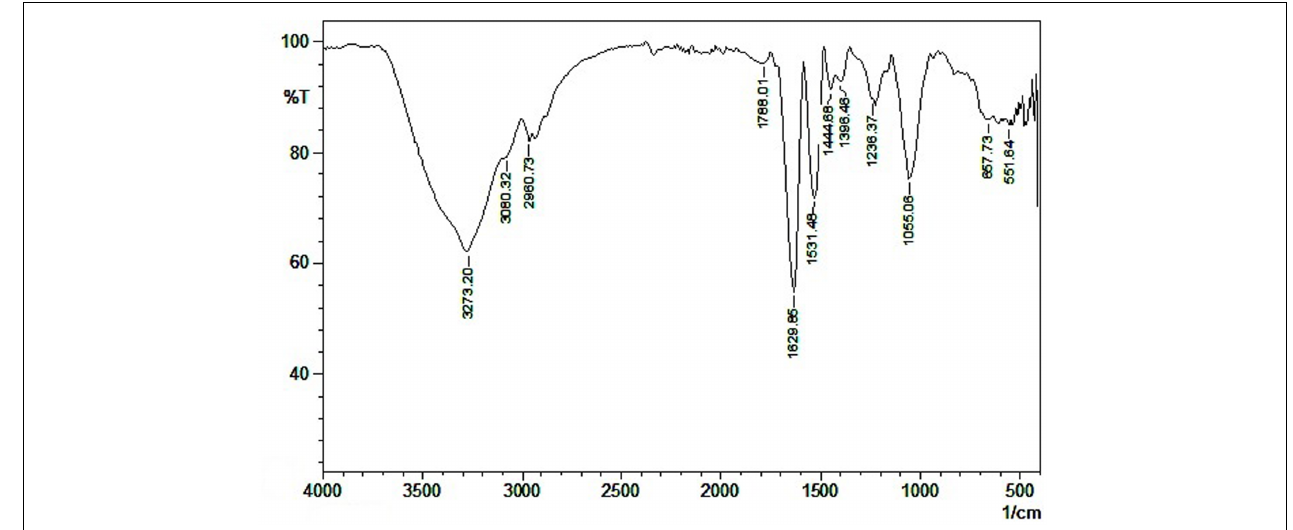
FIGURE 2 | Characterization of biosurfactant produced by MSA31 using